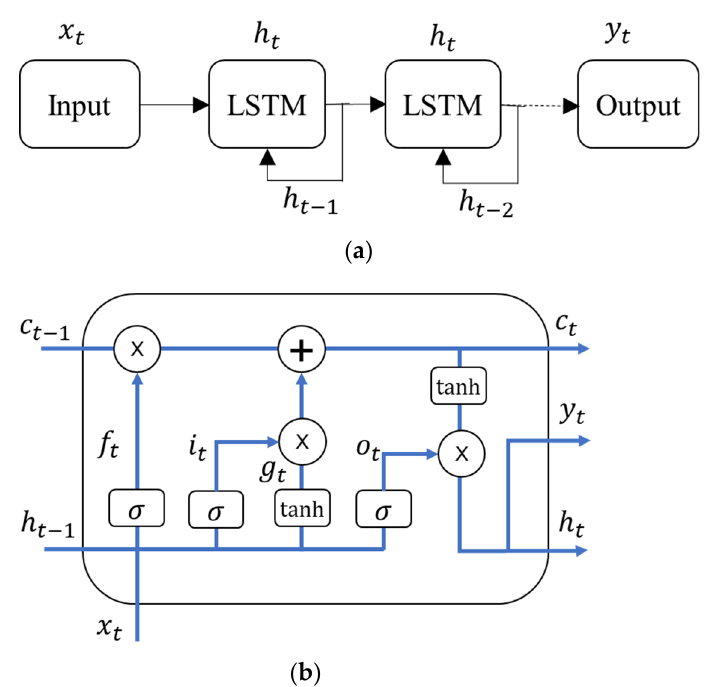
Figure 3. ( a ) Algorithm for several LSTM network layers; ( b ) LSTM cell [29,30].